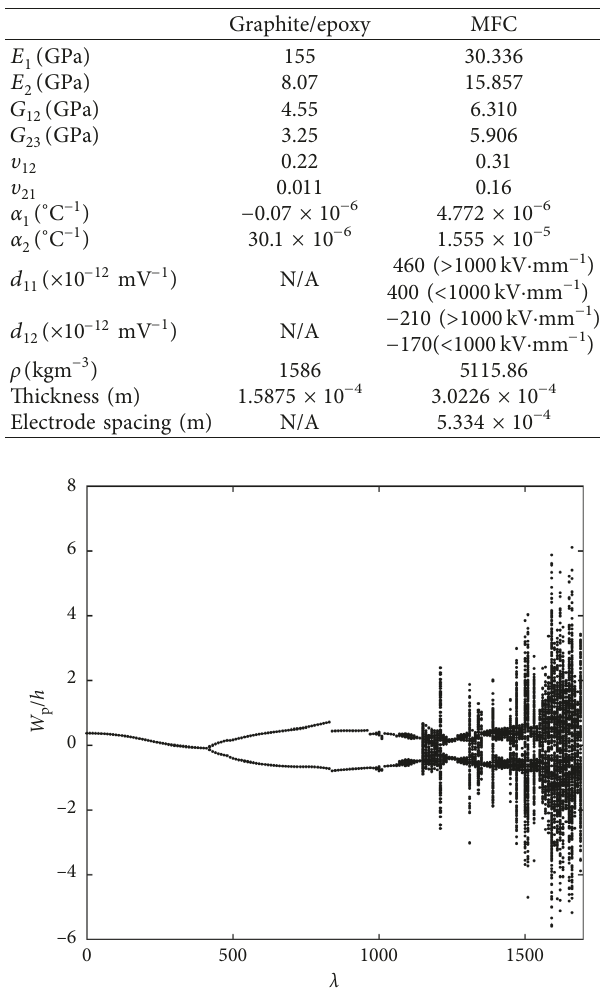
Figure 3: Bifurcation diagram versus dynamic pressure for � H / h � 0 . 2 and Δ T / Δ T cr